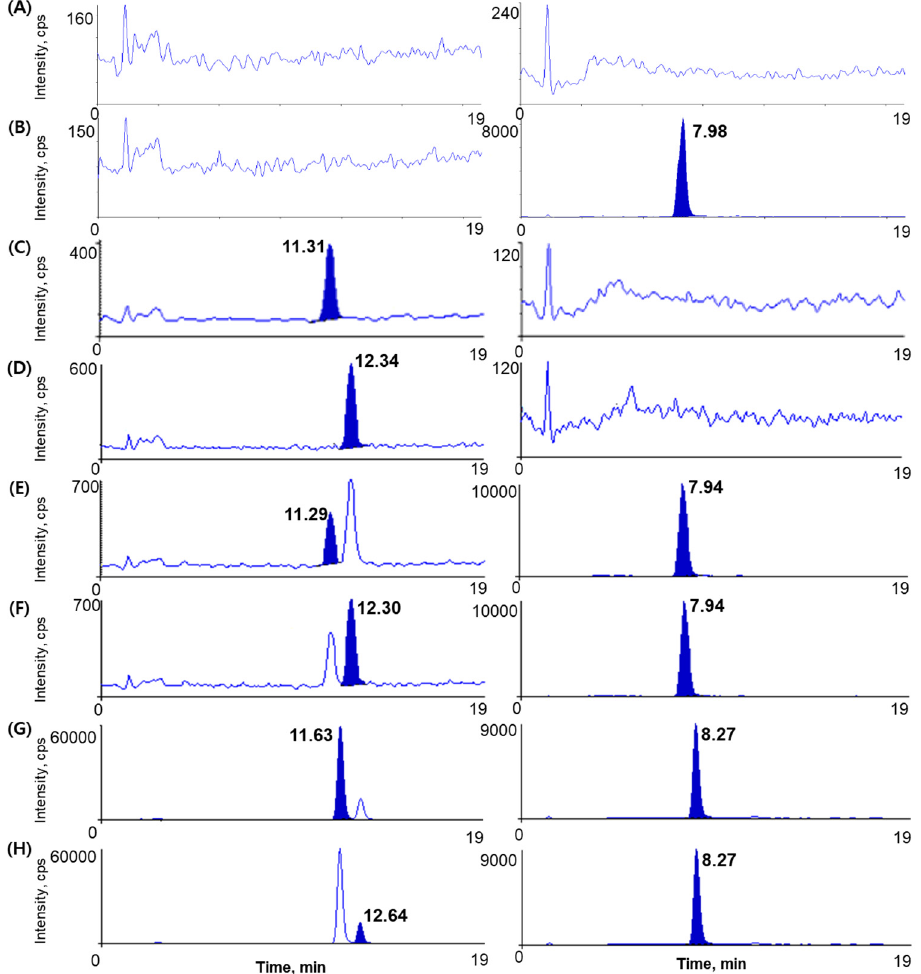
Figure 2. Chromatograms of ( A ) Blank human plasma, ( B ) Blank plasma spiked with IS (5 µg/mL), ( C ) Blank plasma spiked with ephedrine only (0.2 ng/mL, LLOQ), ( D ) Blank plasma spiked with pseudoephedrine only (0.2 ng/mL, LLOQ), ( E ) Blank plasma spiked with ephedrine (0.2 ng/mL) and IS (5 µg/mL), ( F ) Blank plasma spiked with pseudoephedrine (0.2 ng/mL and IS (5 µg/mL), ( G ) Ephedrine (measured concentration 27.23 ng/mL) in sample plasma from a patient 1 h after admin- istering an oral dose of 14.47 g OJS powder and IS (5 µg/mL), and ( H ) Pseudoephedrine (measured concentration 4.08 ng/mL) of sample plasma from a patient at 1 h after administering an oral dose